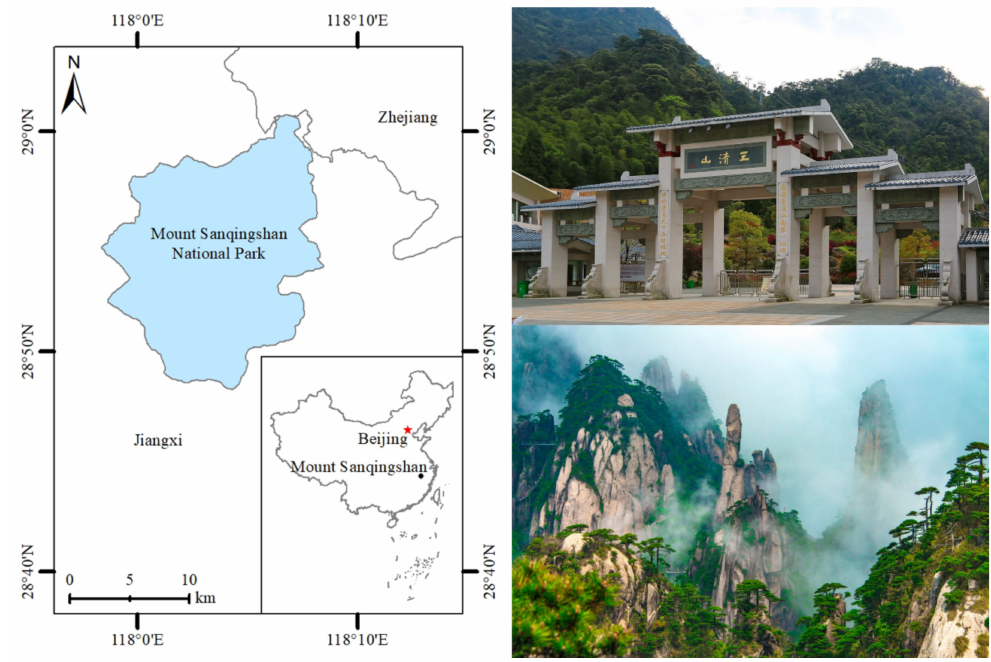
Figure 2. The geographical location and panoramic view of